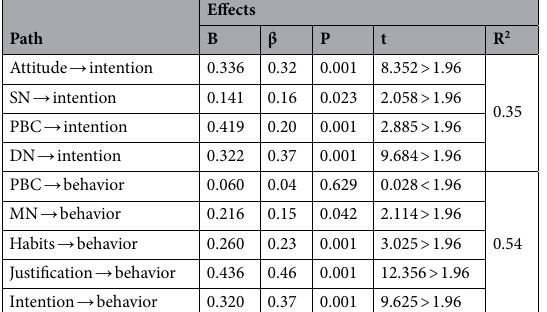
Table 3. The effect of forecasting variables in ETPB. β: Standardized factor loading; B: Non-standard factor loading, P: Significant at level (0.05 or